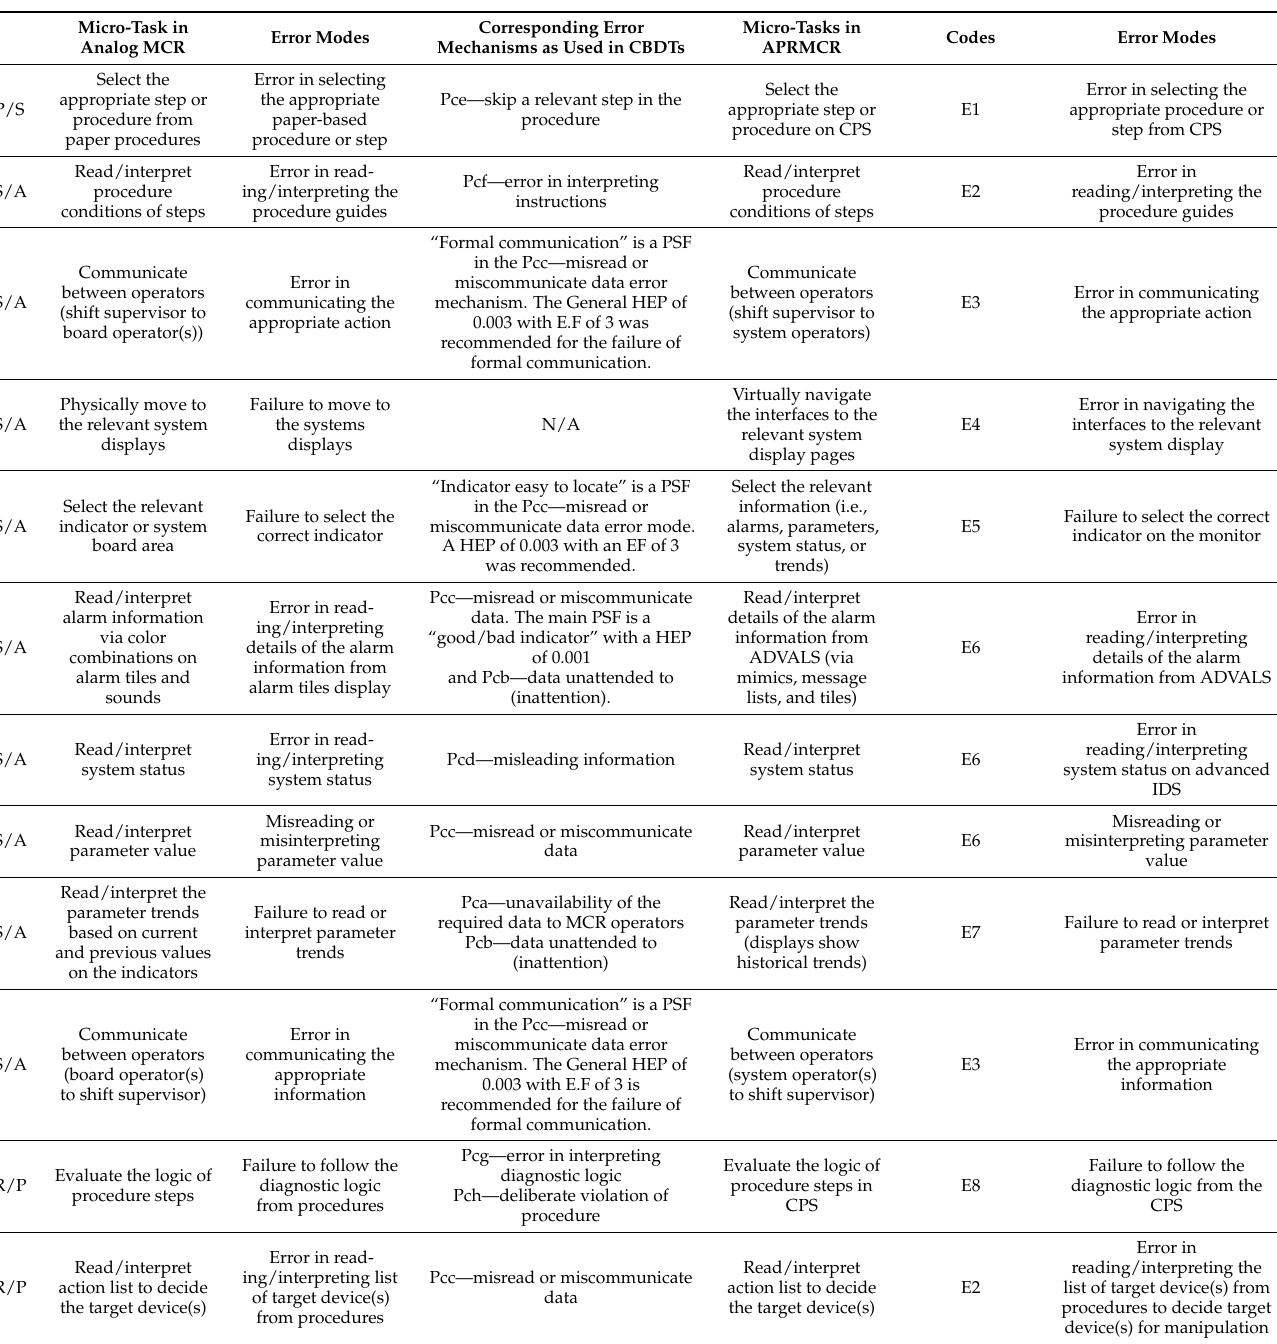
Table 1. Comparison of micro-tasks of conventional MCRs versus